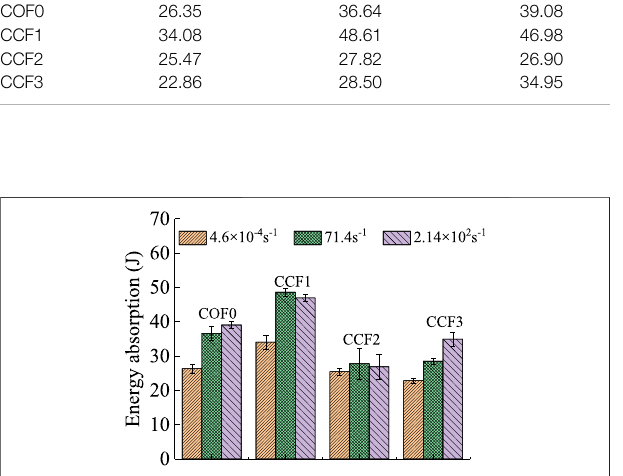
FIGURE 9 | Comparison of energy absorption for the specimens COF0, CCF1, CCF2, and CCF3 under different strain